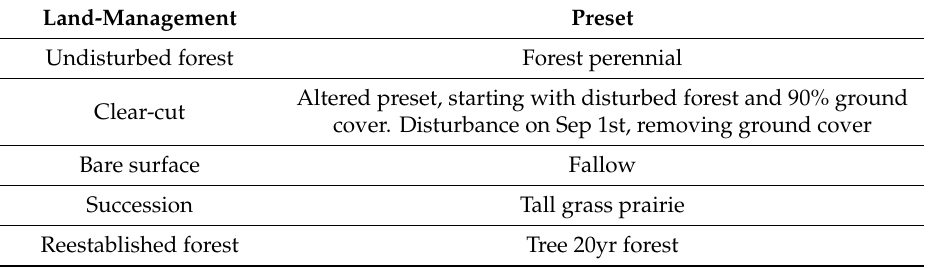
Table 4. Land-management stages and WEPP presets